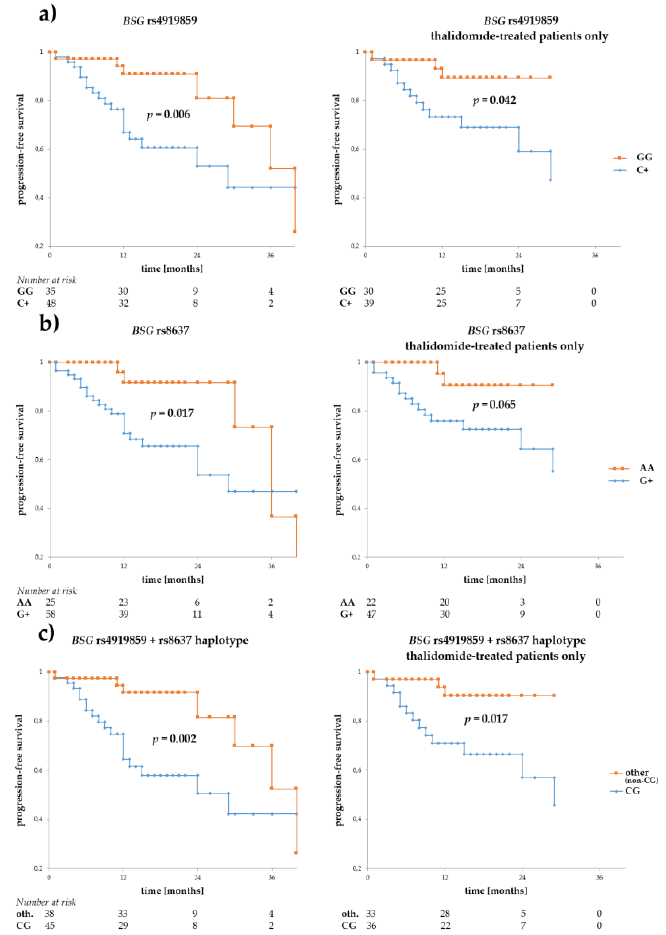
Figure 2. Progression-free survival in multiple myeloma (MM) patients with respect to BSG SNPs. Panels ( a , b ) show survival for rs4919859 C and rs8637 G, respectively. The two SNPs, located in a presumed transcription factor and microRNA binding sites, are in low/medium LD. Given their similar effect on progression-free (PFS), an rs4919859 C and rs8637 G (or CG, in short) haplotype was also tested for association with PFS, and is shown in panel ( c ). Curves to the left show PFS calculated for the entire group of patients, while those to the right show PFS calculated for the subgroup of thalidomide-treated patients. The numbers at risk show numbers of patients in the risk set (i.e., patients without disease progression, a number used to calculate survival) at a given time point on the x -axis. Survival was calculated using the Kaplan-Meier method and the real statistics resource pack for Microsoft excel 2013